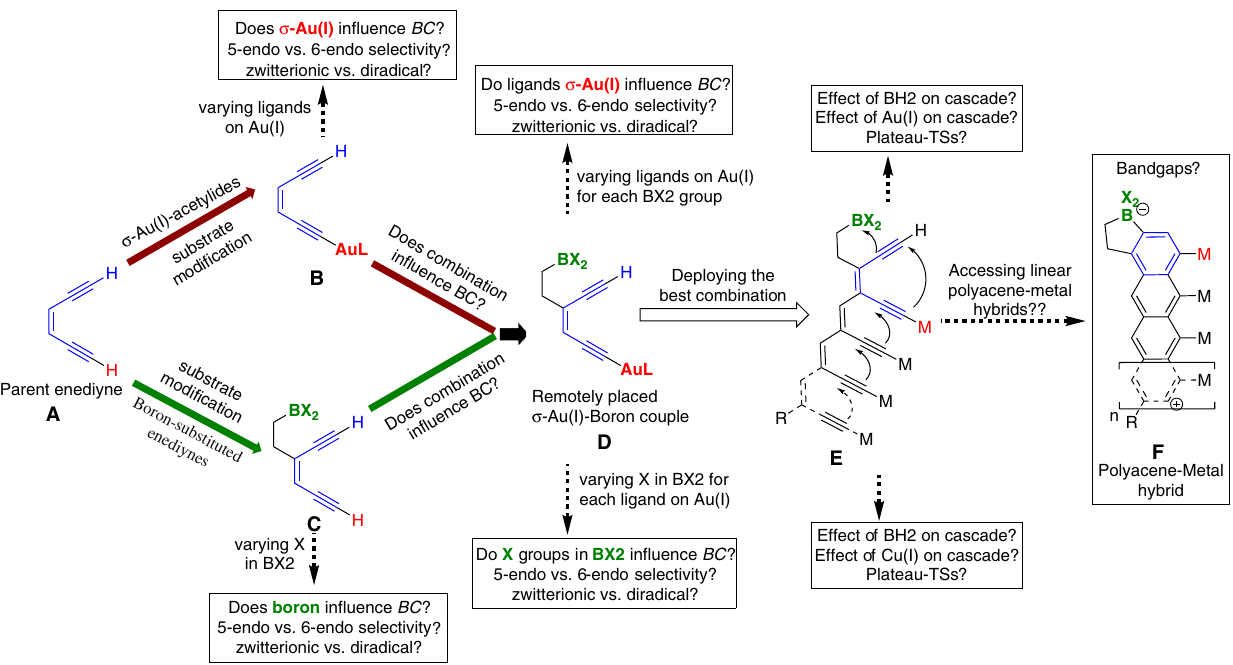
Fig. 4 The fl ow chart provides a logical evolution of substrates from the parent enediyne into multifaceted polyenynes that can form polyacene-metal hybrids. Each modi fi cation in the substrate design was investigated separately using DFT level calculations [ A (Parent enediyne) → D (Au/boron couple) ]. Structures B and C correspond to mono σ -Au(I) and mono boryl substituted enediynes. Structure E corresponds to the polyene containing the best combination of Au(I)/boryl couple. Structure F corresponds to the metal-substituted polyacenes product.